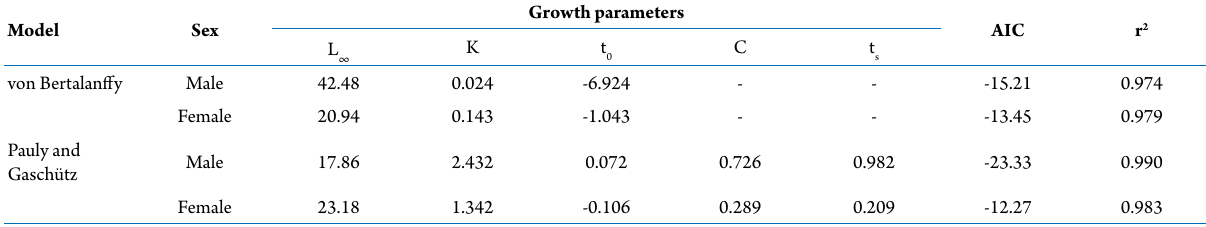
Table 2. Growth parameters obtained from fitting two growth models to mean carapace lengths at ages of Macrobrachium lamarrei (L = asymptotic carapace length (mm), K = growth coefficient, t ∞ oscillation, and t = age at the beginning of growth oscillation). s